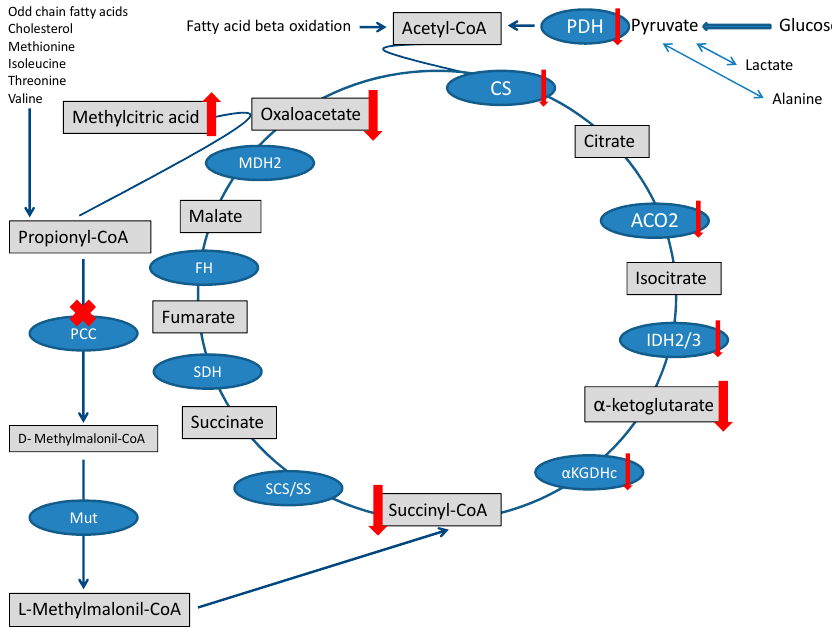
Figure 1. PRISMA flow diagram of study selection.